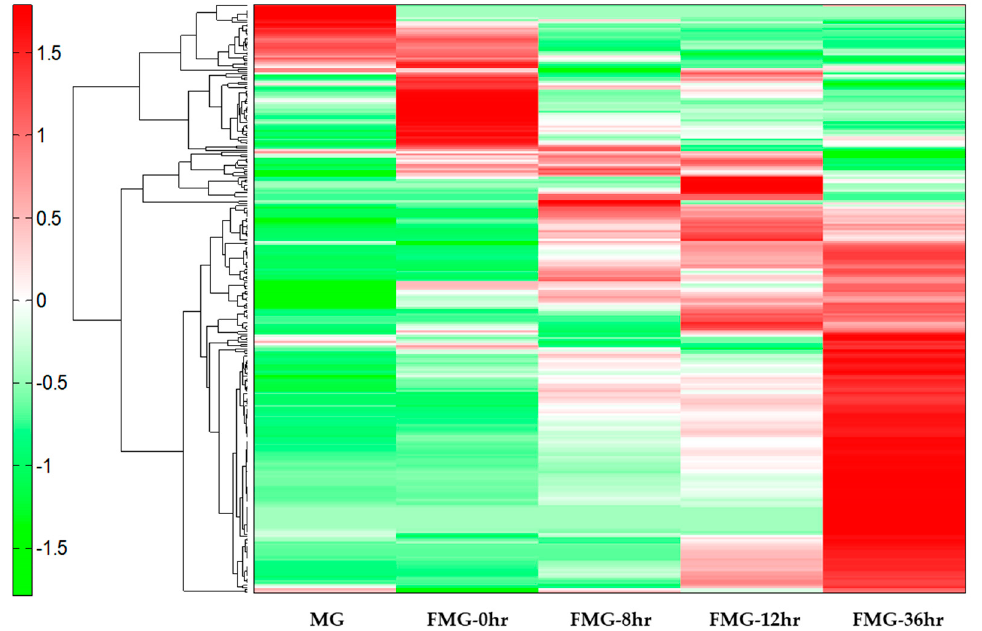
Figure 1. An hierarchical cluster analysis (HCA) heatmap comparing the metabolites from the mixed grains (MG) during fermentation. The x-axis shows MG (a grain mixture before steaming), fermented mixed grains (FMG)-0hr (a mixture of grain steamed for 30 min at 100 °C), FMG-8hr (a mixture of grain fermented for 8 h), FMG-12hr (a mixture of grain fermented for 12 h), and FMG-36hr (a mixture of grain fermented for 36 h) for each metabolite. The green and red colors indicate lower and higher contents of the metabolites, respectively.